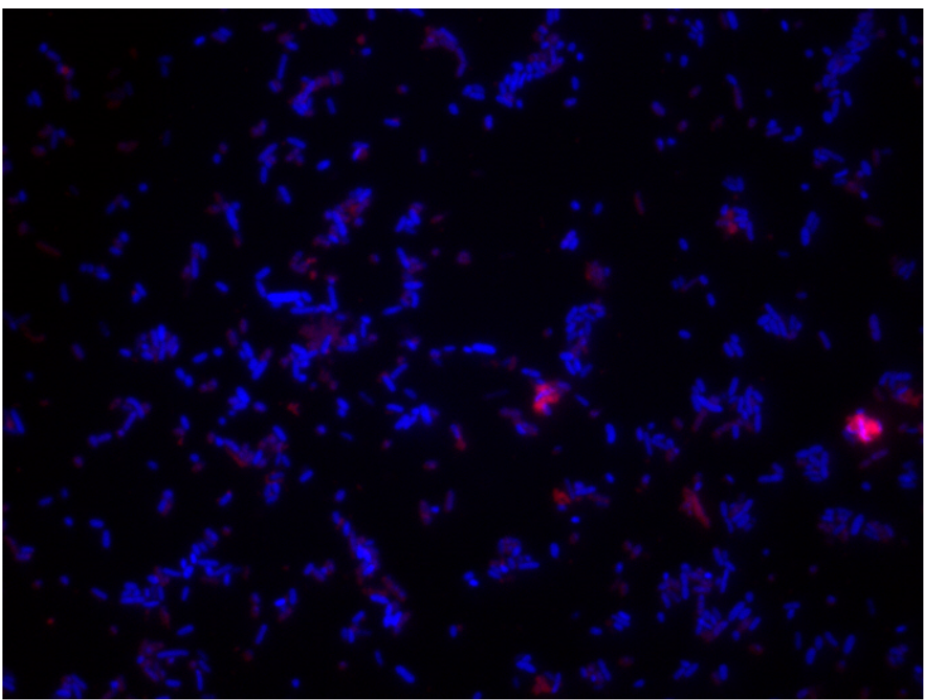
Figure 7. Pseudomonas fluorescens biofilm (24 h) on the stainless steel. Coupons stained with DAPI (0.1 mg/mL; 10 µ L) and Rhodamine B (0.1 mg/mL; 10 µ L) (Magnification × 100).